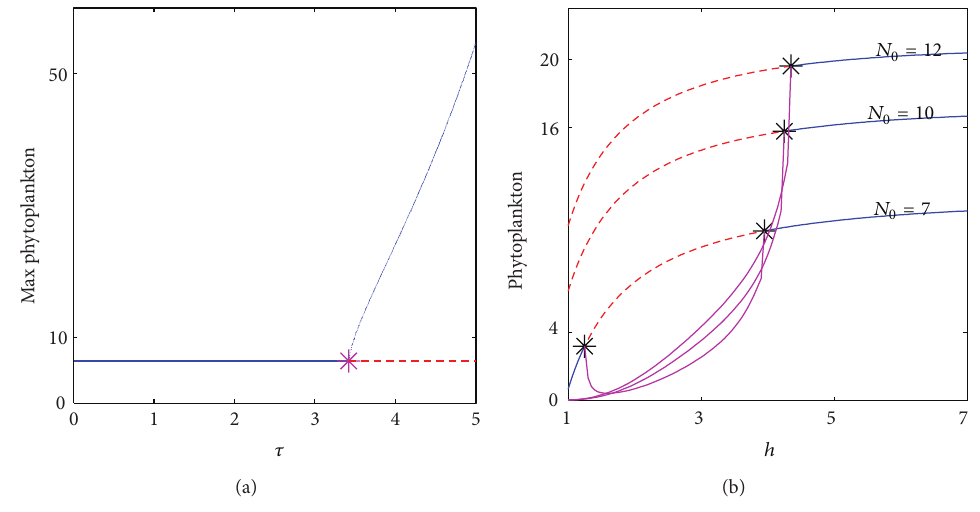
Figure 4: The stable state bifurcation: (a) 𝑁 0 = 10 and ℎ = 1 are fixed; (b) 𝜏 = 6 is